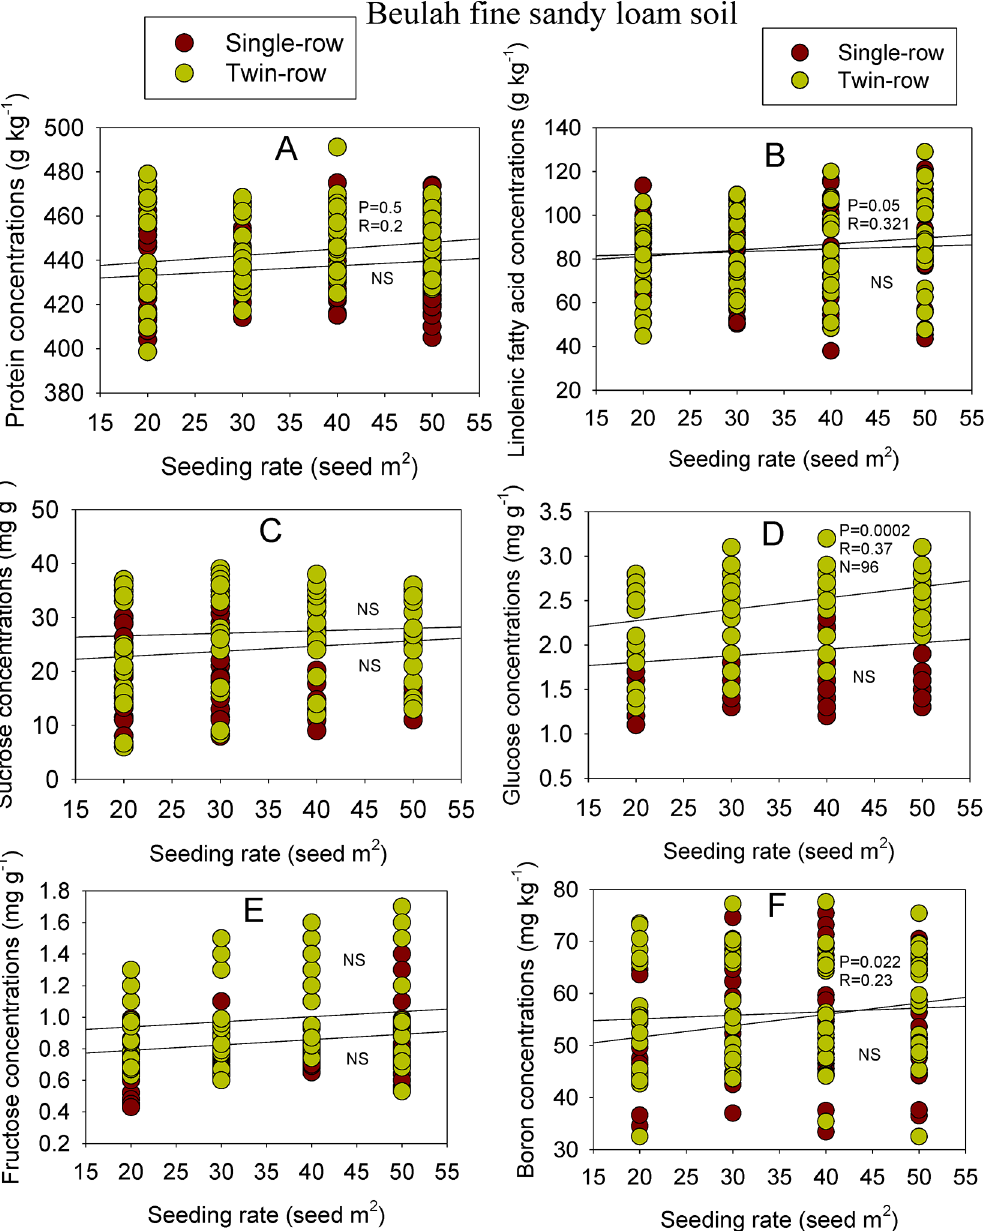
Fig 2. Correlation between seeding rate (SR) and soybean seed protein (A), linolenic fatty acid (B), sucrose (C), glucose (D), fructose (E), and boron 9B0 (F) on single- and twin-rows in sandy loam soil across cultivars and